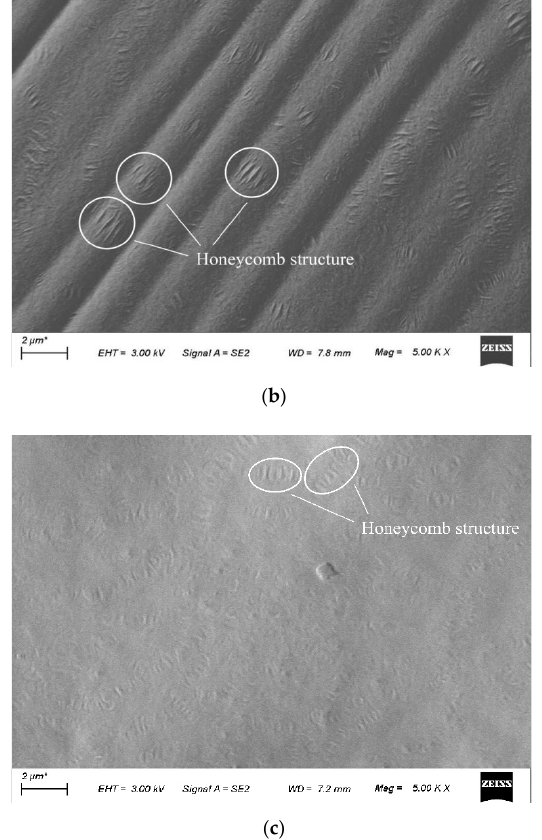
Figure 11. Micromorphologies of different asphalts under SEM (5000 times). ( a ) Base asphalt. ( b ) Aged asphalt. ( c ) R-8%.